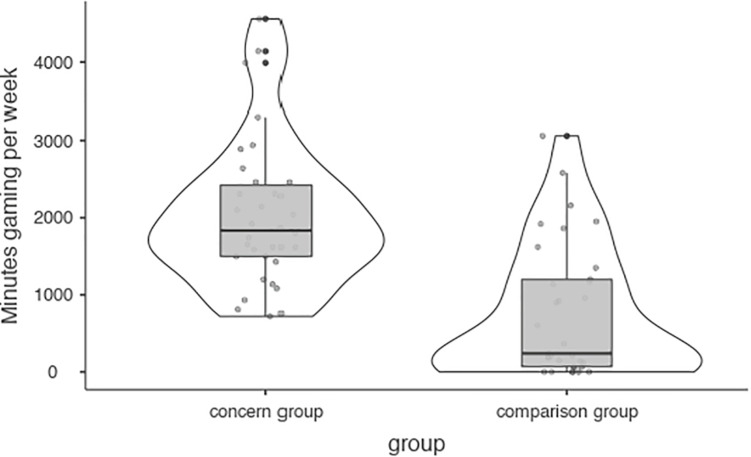
Minutes gaming per week.